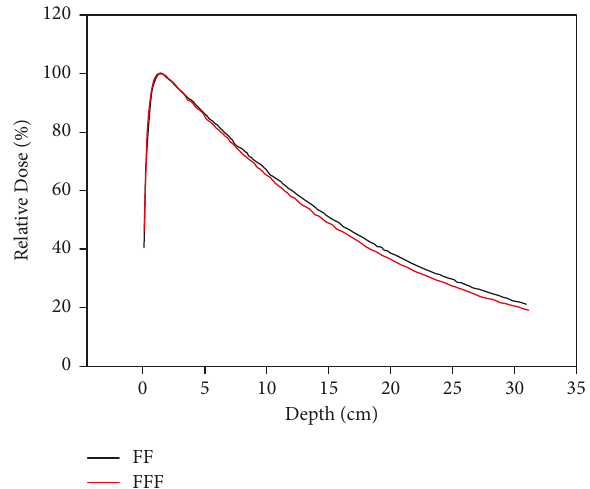
Figure 8: The comparison of simulated PDDs formed by FF beam and FFF beam for 10 × 10cm 2 field. The black line represents the FF beam result and the red line represents the FFF beam result.